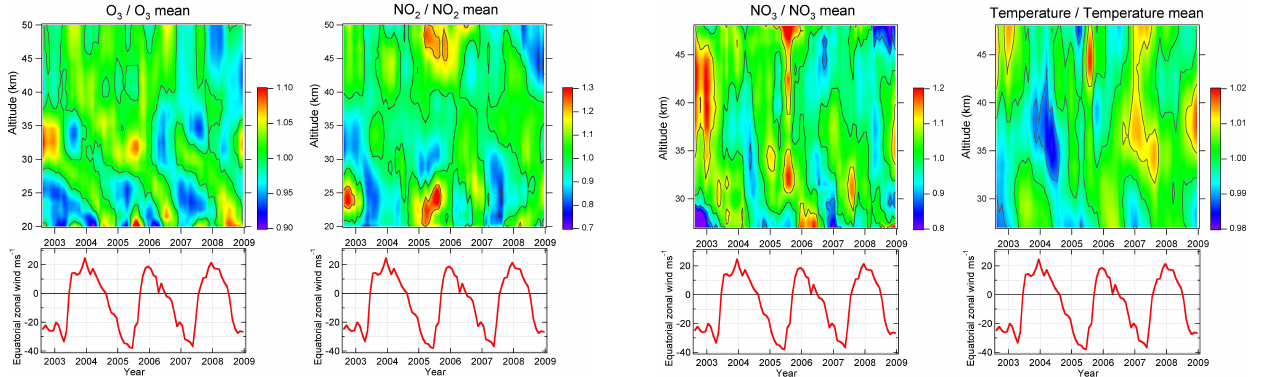
36km and positive again between 36 and 45km. Below 22km the signal is less clear, probably due to the increase of measurement un- certainties. Fig. 4 shows clearly that the variation of O 3 and NO 2 are correlated or anti-correlated depending on the altitude. This O 3 - NO 2 correlation (Fig. 5) is found to be positive between 20 and 24km, not significant between 24 and 27km, strongly negative be- tween 27 and 38km with a maximum of anti-correlation up to -0.85 at 30km and positive again between 38 and 55km. The relative variation of O 3 is between − 40% to +40% of that of NO 2 . These phase relationships will be discussed in Sect.6.